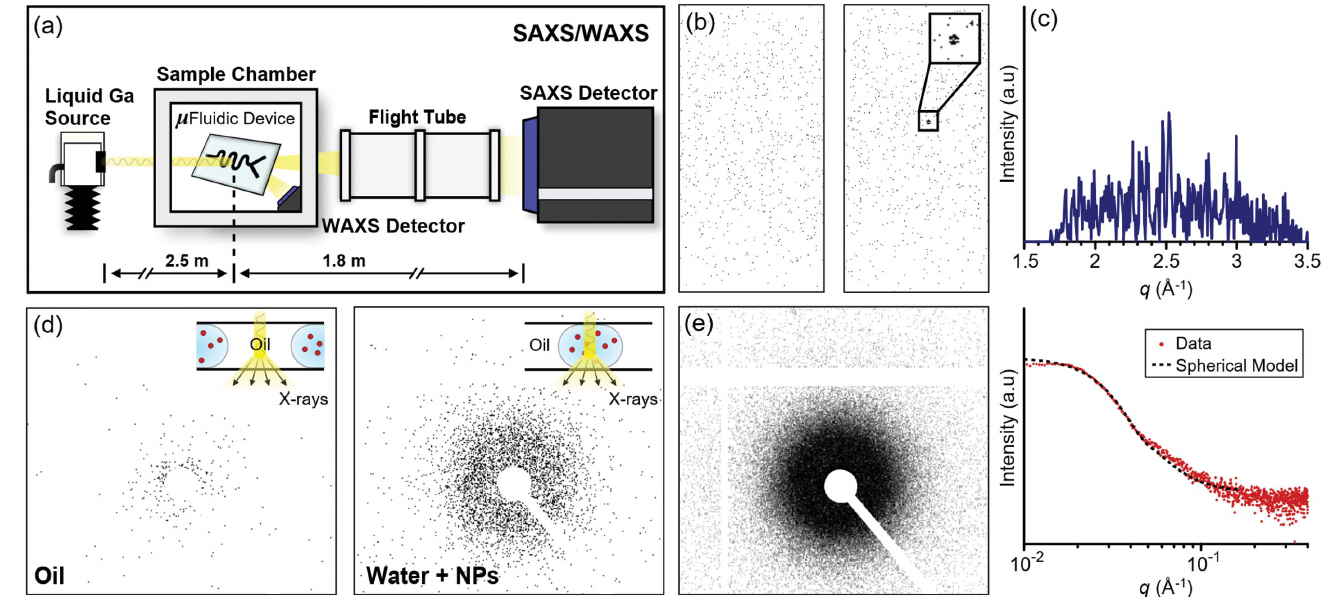
Figure 1 ( a ) Microfluidic experimental setup on the Xeuss 2.0 SAXS/WAXS Laboratory Beamline. ( b ) Representative 2DWAXS patterns from the flow of water- in-oil droplets within the device collected with 0.5 s exposures. The zoomed-in inset shows a possible reflection from the (104) plane of calcite formed during a rapid precipitation process within the droplets. ( c ) Integrated 1D diffraction pattern of the right frame of ( b ) showing that the possible 104 reflection was not preserved during data reduction. ( d ) Representative 2D SAXS patterns collected from 0.5 s exposures that show the characteristic scattering of oil and water droplets containing silica nanoparticles. The insets illustrate the path of the X-ray beam through the microchannel, either encountering the continuous oil phase or a droplet containing nanoparticles. ( e ) Serial 2D (left) and 1D (right) SAXS patterns of silica nanoparticles obtained from automated combination of multi-frame scattering data (30 s cumulative exposure time). The dotted line is a polydisperse sphere form factor fitted to the I ( q ) curve taking into account beam